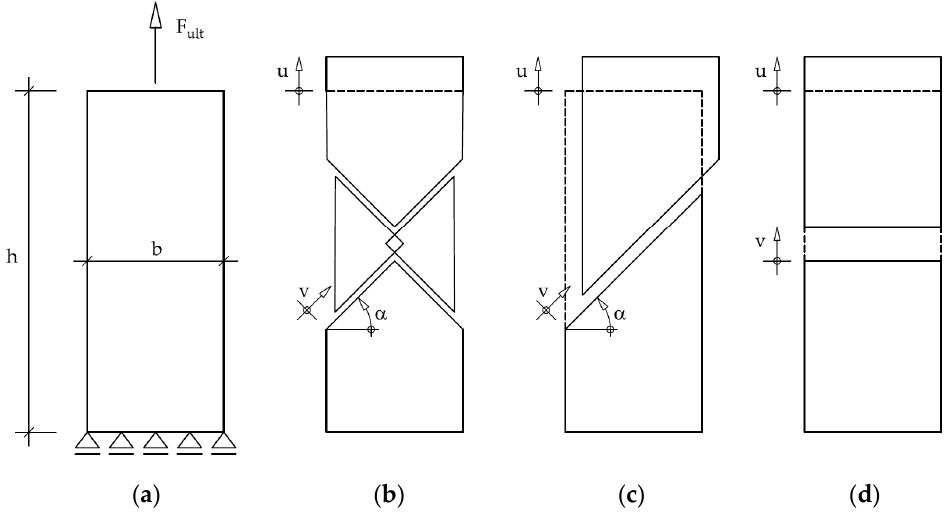
Figure 3. Tensile specimen: ( a ) Loading and boundary conditions; ( b ) symmetrical slip line mechanism; ( c ) asymmetrical slip line mechanism; ( d ) yield zone